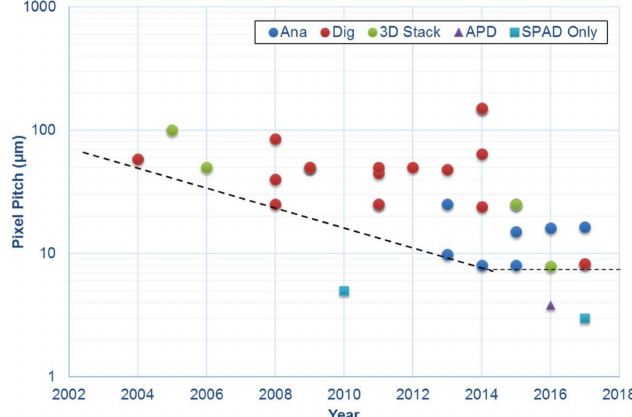
Figure 2. Pixel pitch compared by year of publication for a variety of CMOS SPAD image sensor pixel architectures (analogue or digital monolithic, and all-digital 3D stacked) with a dotted line indicating the trend on reducing pixel pitch now limited at 7.83 µ m [12]. Three notable exceptions sit outside this trend, two SPAD diode test structures (SPAD only) at 5 µ m [13] and 3 µ m pitch [14] and 3.8 µ m APD pixel